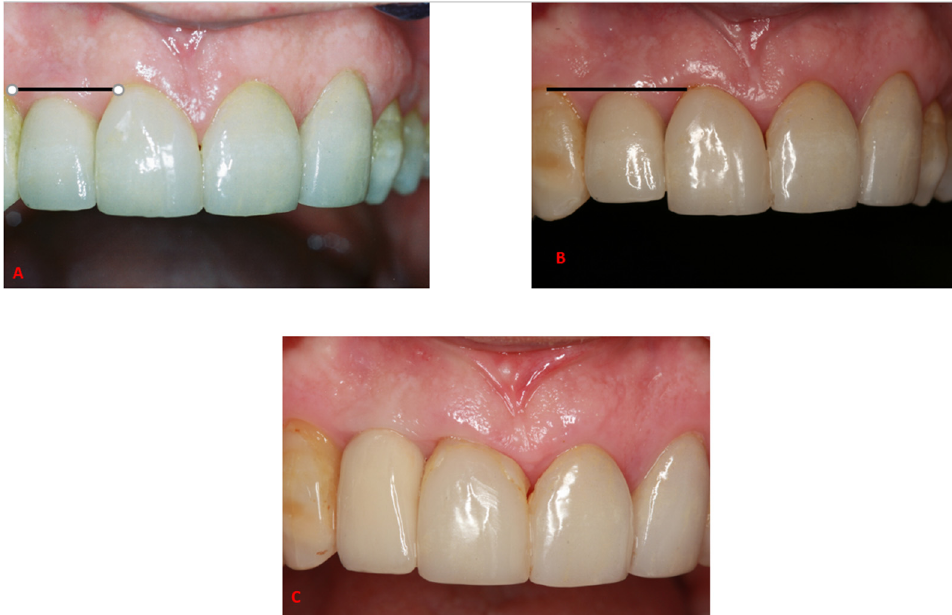
Figure 1. A 59-year-old male patient, 10 years after the placement of a right lateral incisor implant. It can be noticed when comparing the picture from 2003 ( A ) to the one from 2013 ( B ), the submerged position of the crown retained implant of the right lateral incisor in 2013, in comparison to the right central incisor, due to a continuous adjacent tooth eruption, leading to a short and submerged crown and a non-anatomic gingival line and unesthetic incisal line ( B ). ( C ) shows the result after the replacement of the final restoration.